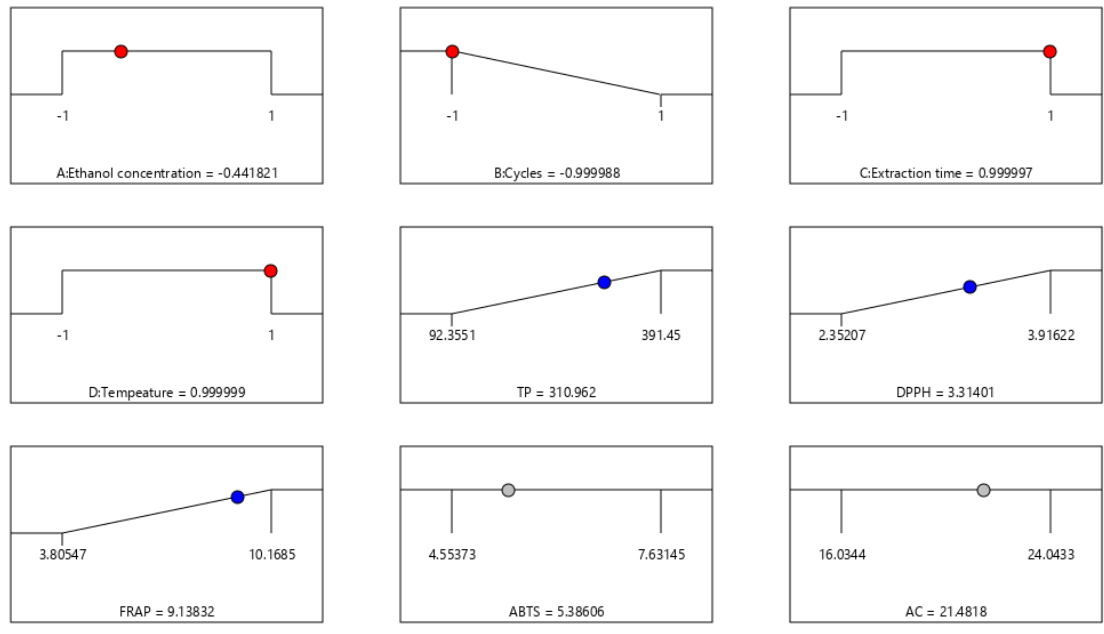
Figure 2. Optimal conditions for recovery of bioactive compounds from Ranco garlic genotype using PLE and predicted values of targeted responses.